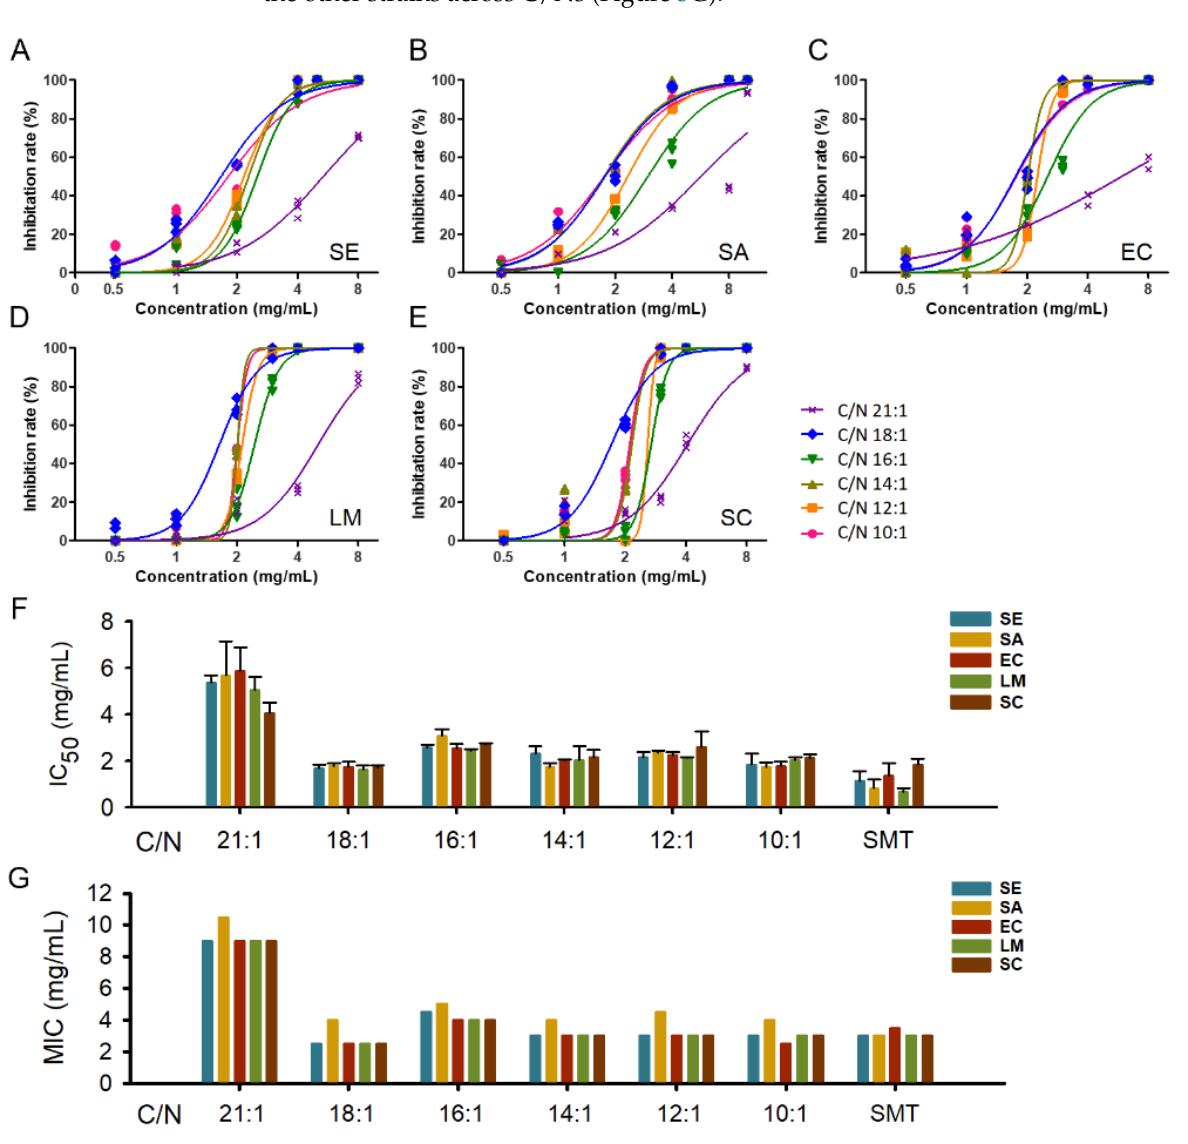
Figure 3. The half and minimum inhibition concentration assay of the crude AMP extracts and the antibiotic control sulfamonomethoxine. ( A – E ), the inhibition curves of five pathogenic strains by AMP extracts; ( F ), the estimated IC 50 and 95% CI; G, the MIC results. SE, Salmonella enterica serovar typhimurium; SA, Staphylococcus aureus ; EC, Escherichia coli O157:H7 ; LM, Listeria Monocytogenes; SC, Shigella Castellani ; SMT, sulfamonomethoxine.